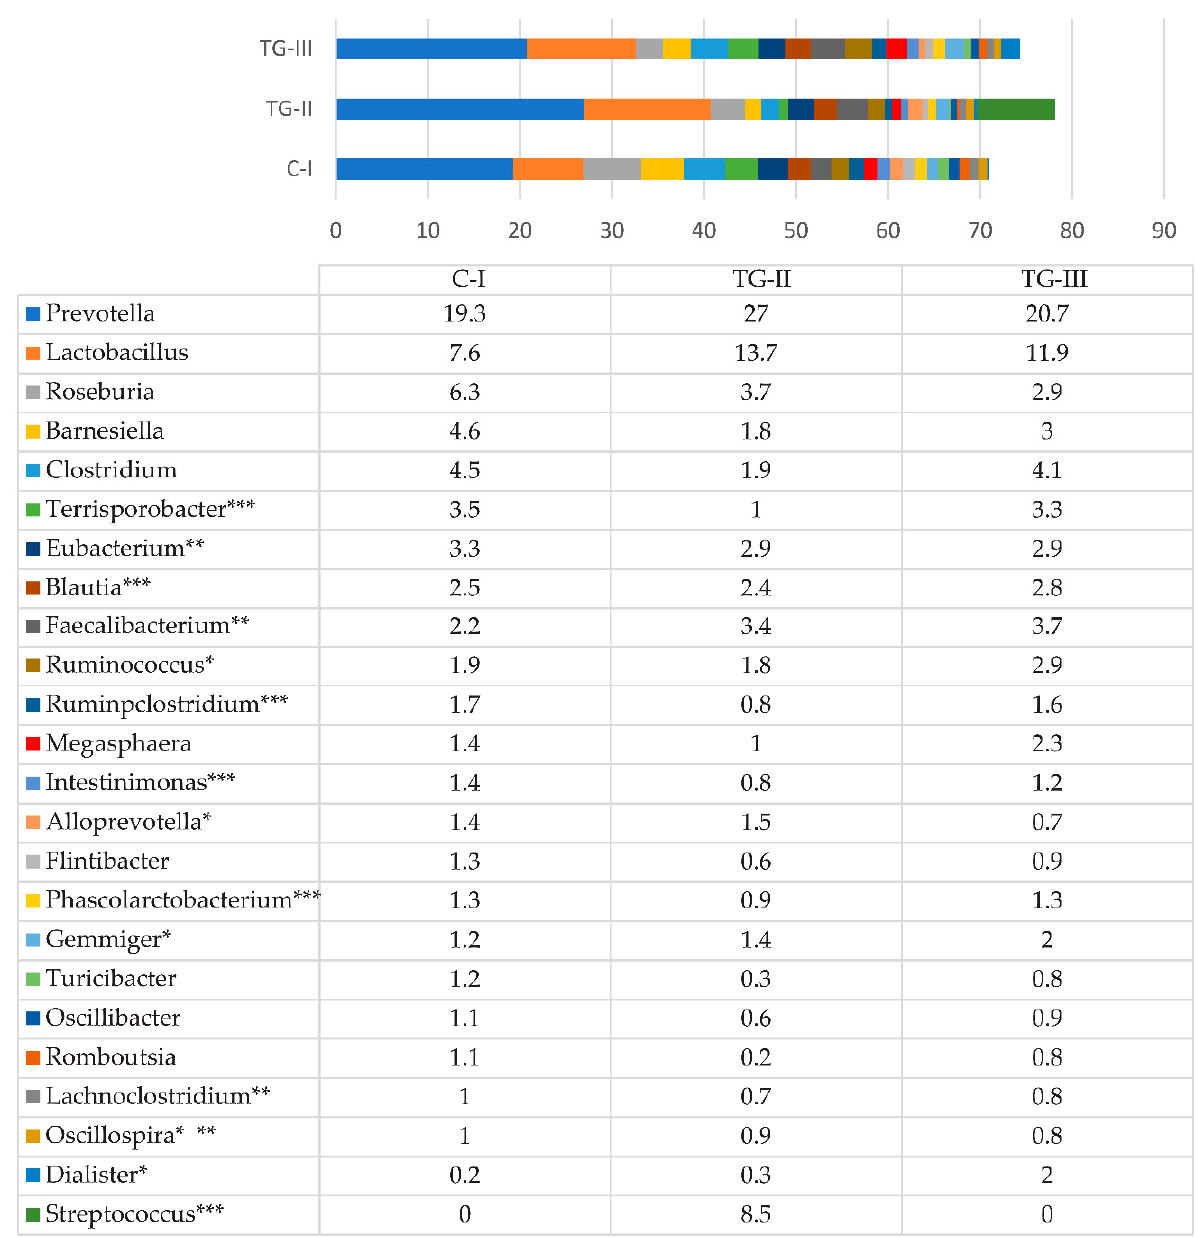
Figure 2. Bacterial composition of piglets’ faeces at the end of the experimental treatment (day 62). The data only represent those genera whose numbers from all the bacterial amounts were at least 1% in any of the animal groups. * Statistically insignificant results between C-I and TG-II. ** Statistically insignificant results between TG-II and TG-III. *** Statistically insignificant results between C-I and